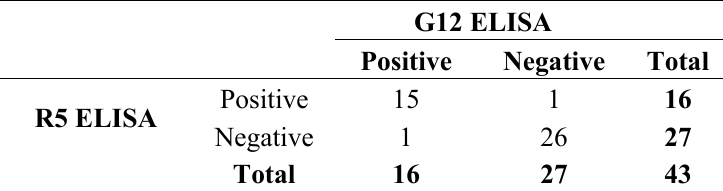
Table 7. Results of the McNemar’s test conducted on all the sample